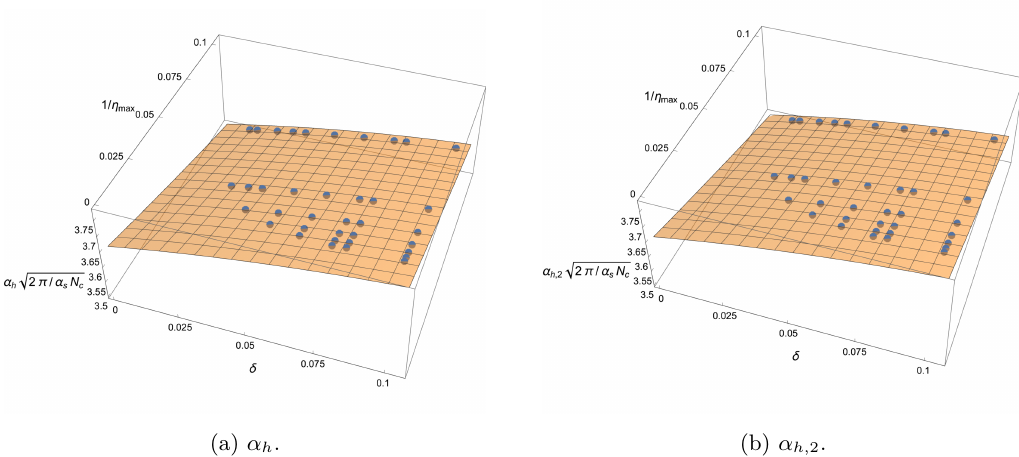
Figure 8. The plots of estimated intercepts, α h and α h, 2 , at each δ and 1 /η max (blue dots), together with the best-fitted quadratic surface given by eq. (6.9) (yellow surfaces). The continuum limit, δ = 1 /η max = 0, corresponds to the lower-left corner of each